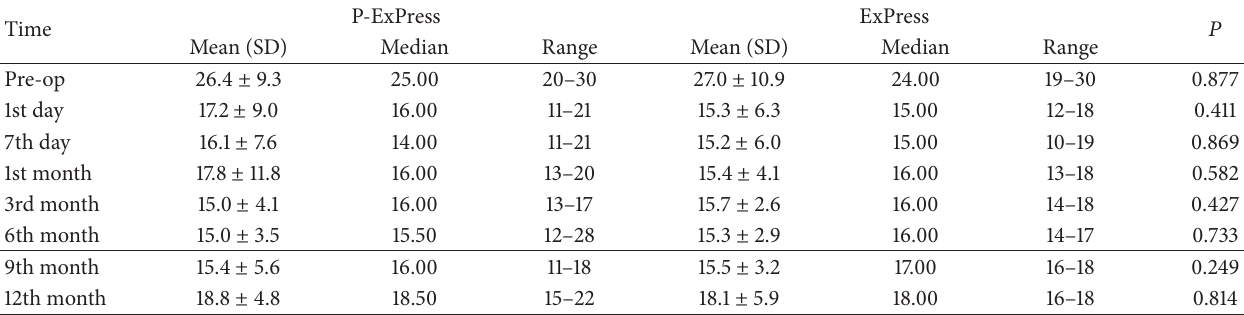
Table 2: Intraocular pressure (IOP) mean values, median values, standard deviations, and range in the phaco-ExPress (P-ExPress) and ExPress (ExPress) groups at specific times after surgery.